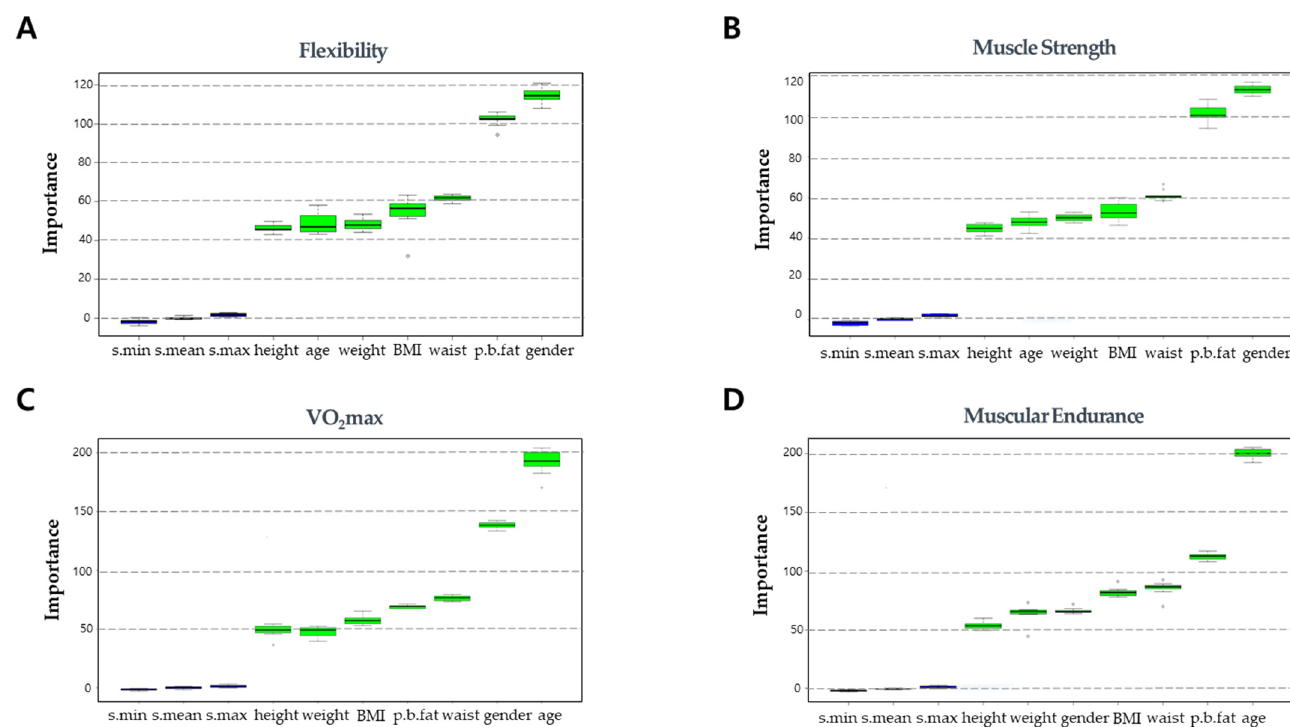
Figure 2. Importance plot demonstrating degree of correlation between input and output variables. S.min, S.max, and S.mean denote the threshold values. ( A ) Importance plot for flexibility, ( B ) Importance plot for muscle strength, ( C ) Importance plot for VO 2 max, ( D ) Importance plot for muscular endurance.